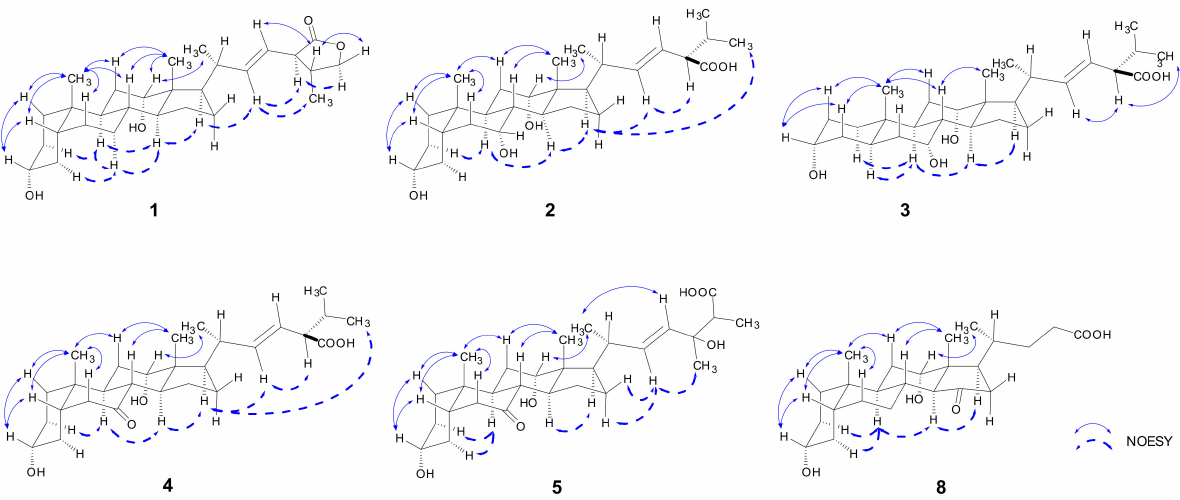
Figure 3. Key NOESY correlations of compounds 1 – 5 and 8 . Solid arrows indicate correlations in the β -orientation; while dashed arrows show correlations in the α